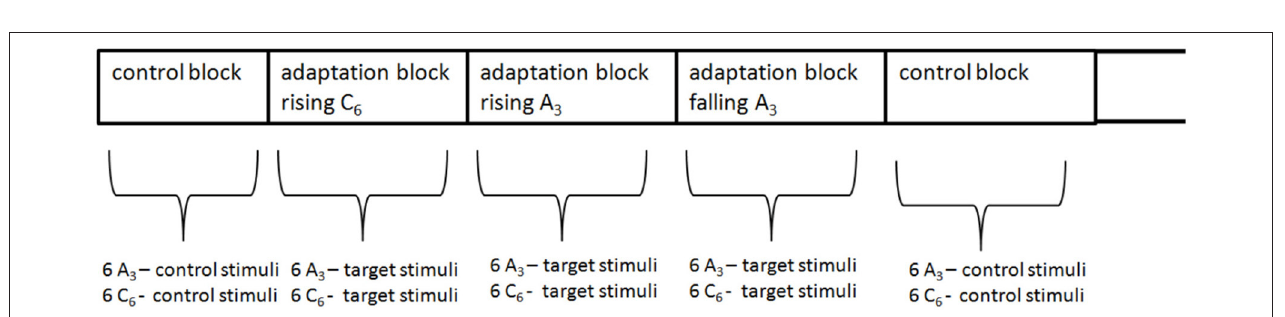
FIGURE 5 | Control and the 4 adaptation blocks were mixed and randomized within the